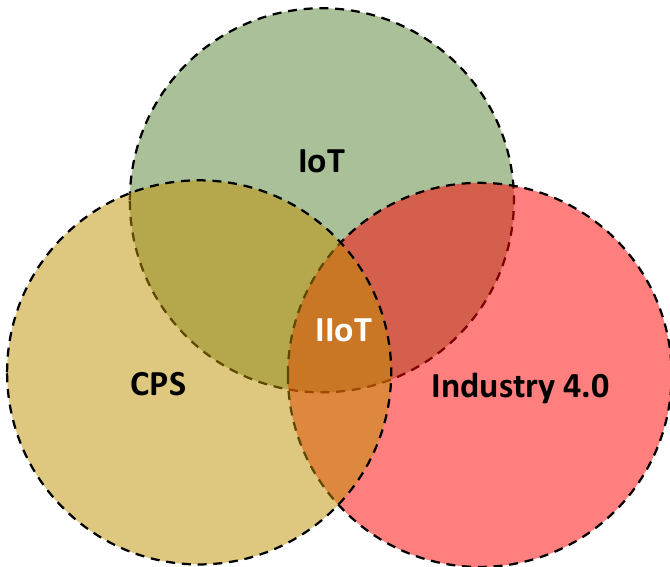
Figure 1. Relationship among IoT, CPS, Industry 4.0, and